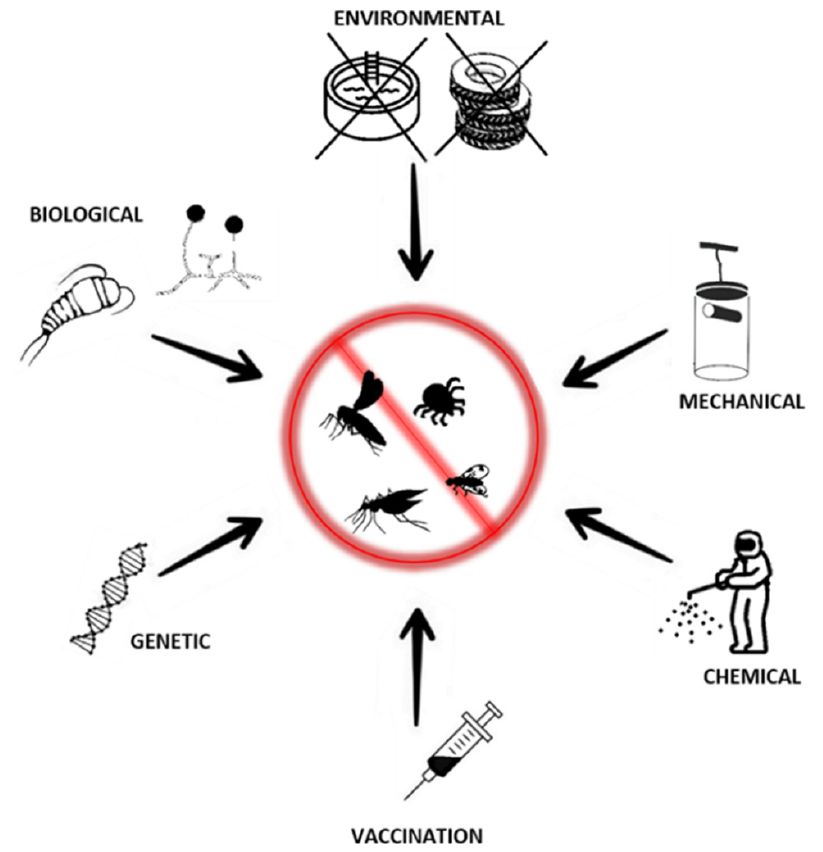
Figure 3. Prevention measures of arboviral disease control.